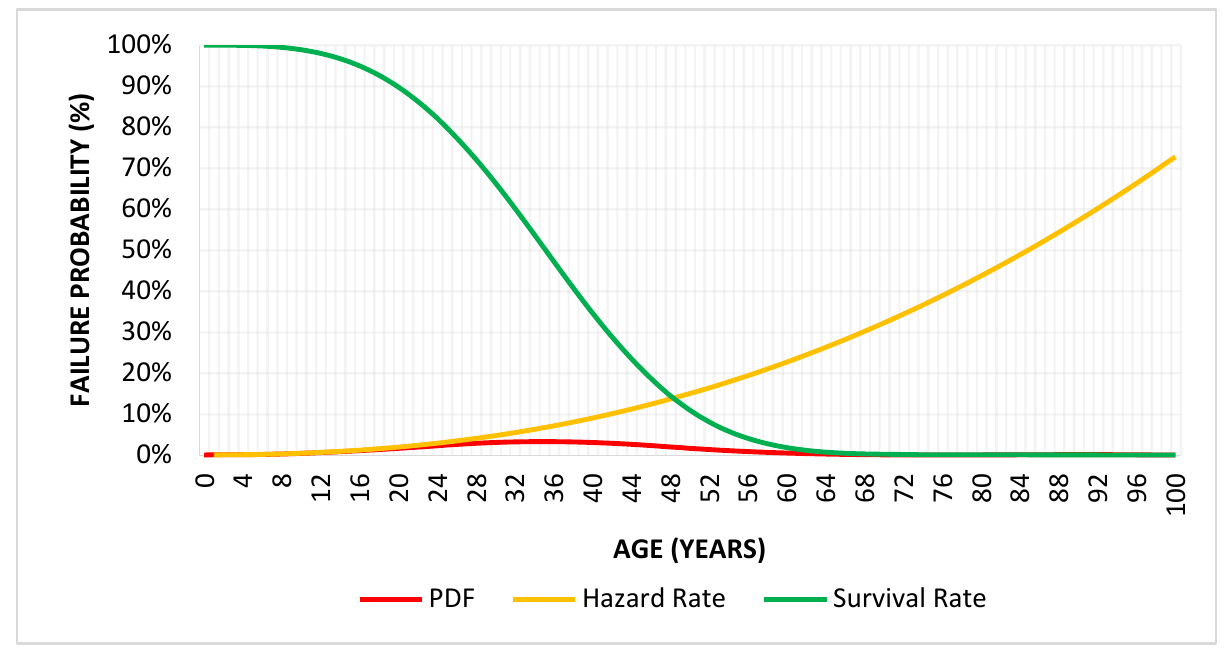
Figure 11. Weibull curve of survival and hazard rates vs effective age.